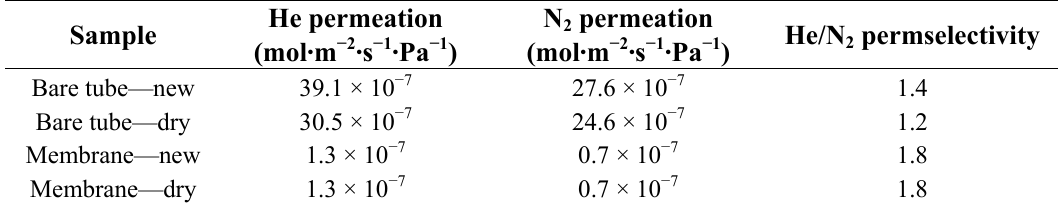
Table 1. Permeation of He and N before and after drying at 100 °C in air for 1 h. For reference, the Knudsen permselectivity of He to N is 2